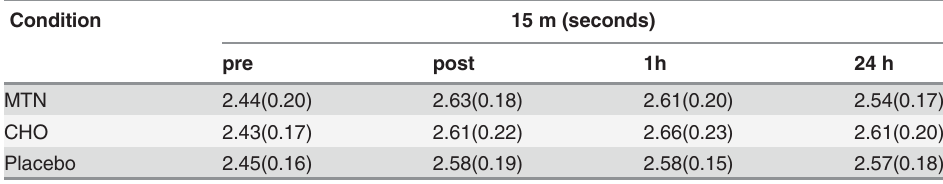
Table 2. Fifteen-meter sprint times (s) measured at before (pre), immediately after (post), and 1 h (1h) and 24 h (24h) after intermittent repeated sprint